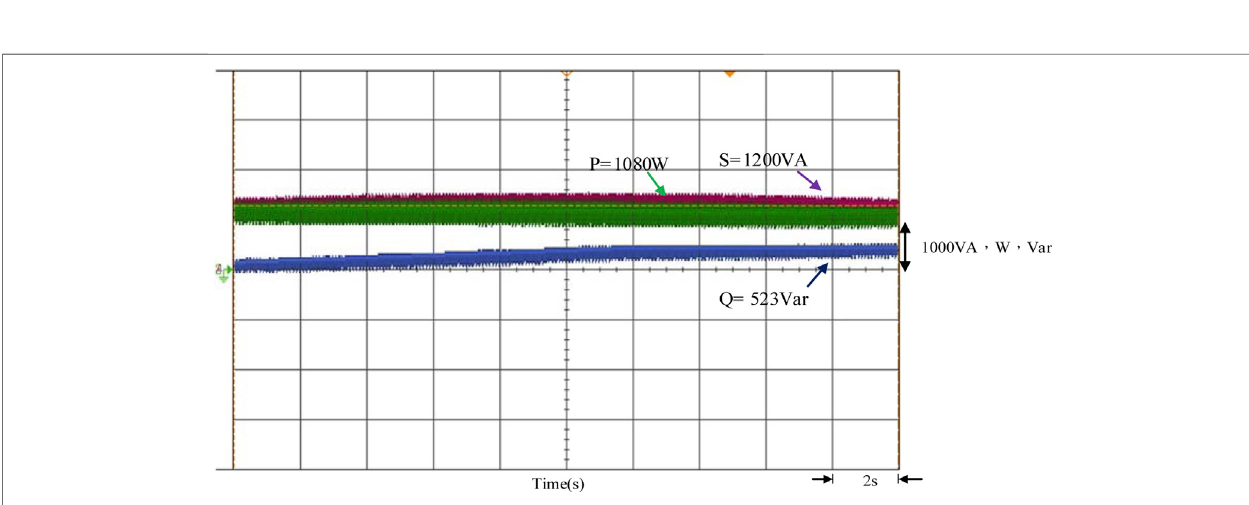
FIGURE 18 | The measured output power regulation of the smart inverter when the grid voltage per unit value is between 1.0 and 1.03 p.u.